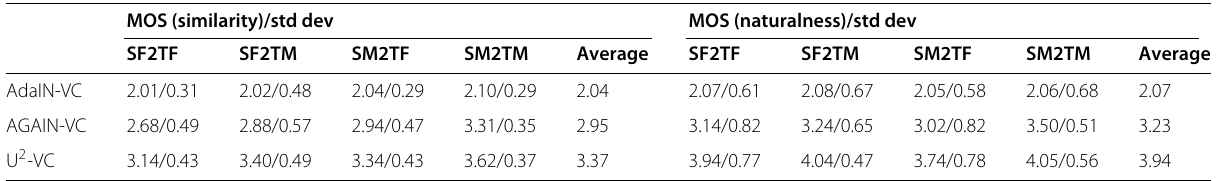
Table 9 Subjective comparison results with standard deviation (std dev) of mono-lingual conversion in unseen-to-unseen scenario. The results are listd as MOS/std dev